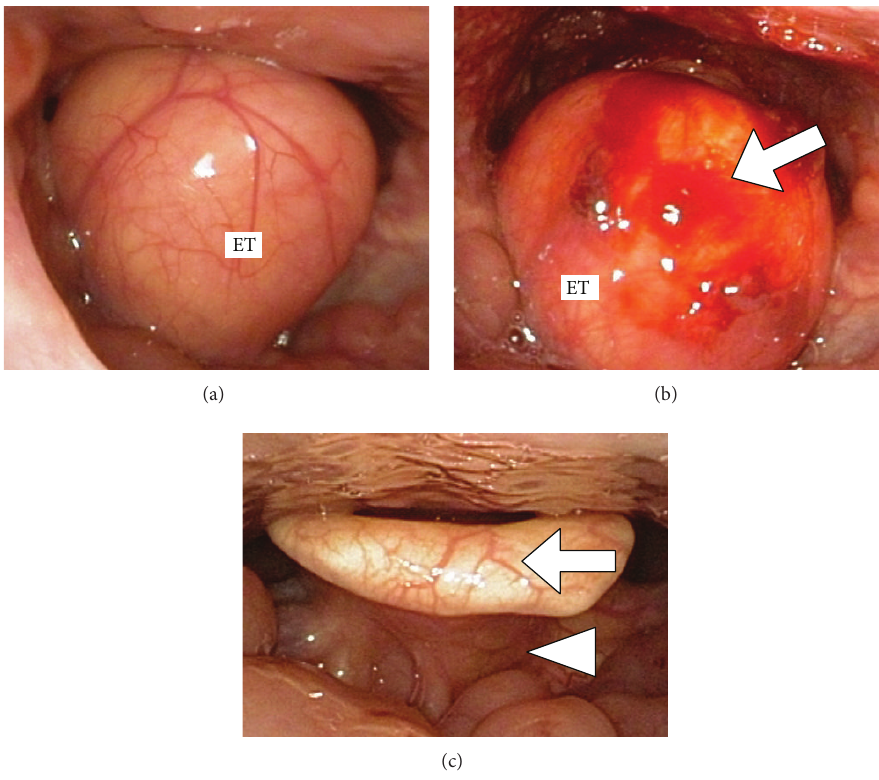
Figure 1: Findings of flexible laryngeal endoscopy. (a) The root of the tumor was unable to be visually distinguished to arise from the lingual or laryngeal surface. (b) No liquid was drained from the tumor after the anterior wall was punctured (arrow). (c) The epiglottis was not deformed (arrow), and its lingual surface was free from postoperative recurrence of the lipoma (arrow head).